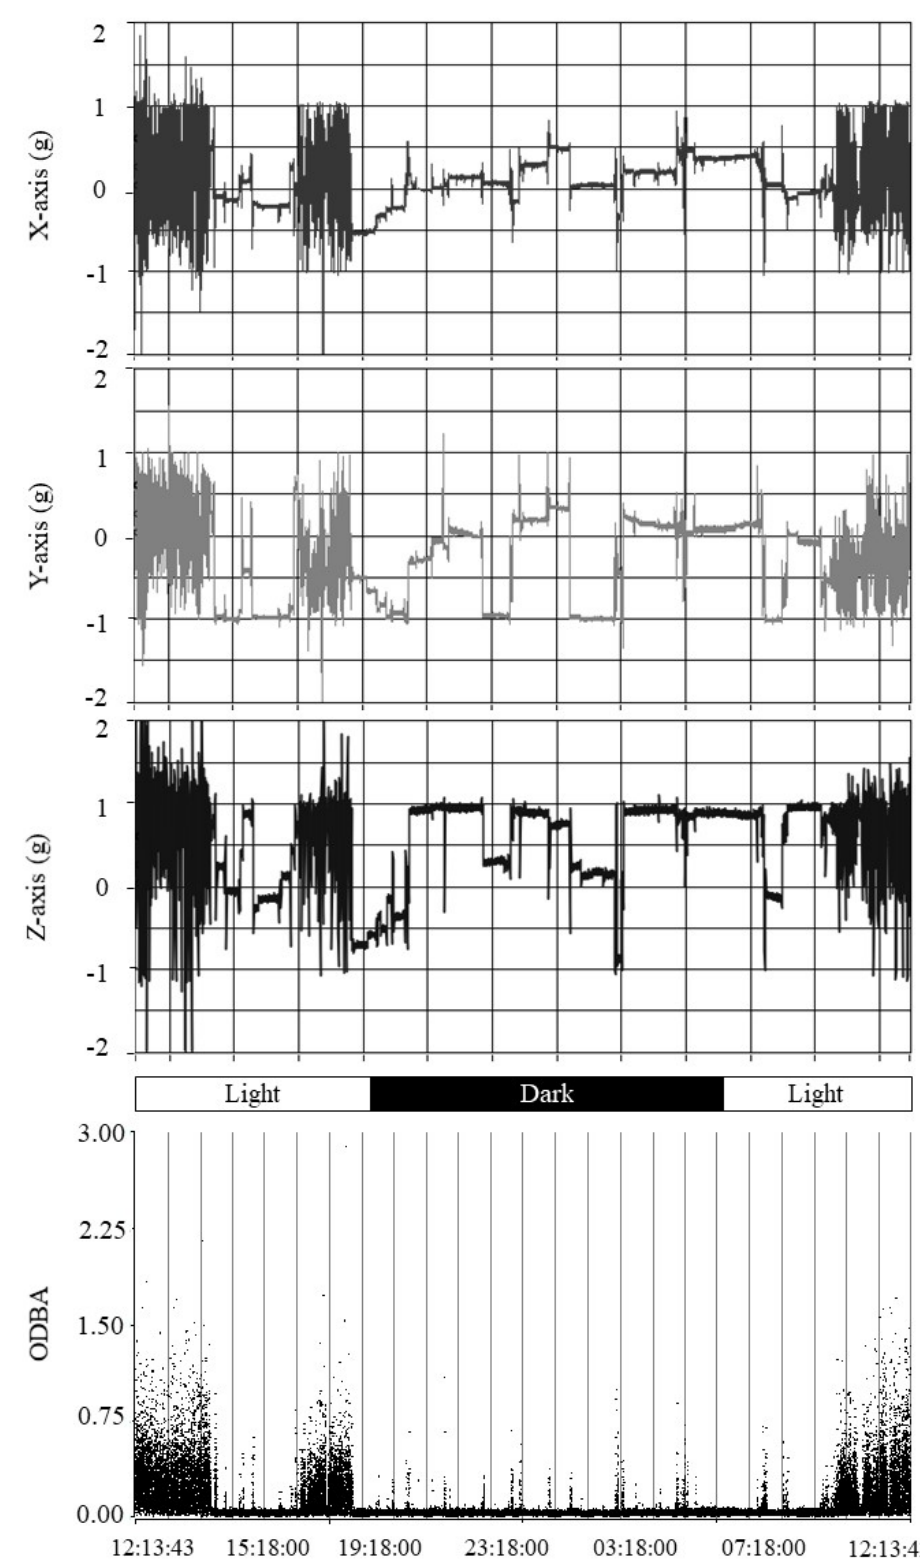
Figure 7. Profiles of the accelerometer data series (Panel A) and ODBA dot plot (Panel B) obtained during the 24 h pilot test carried out on an adult Tamandua tetradactyla individual exposed to semi- controlled conditions in its enclosure. Panels A–C: X, Y and Z axes. Panel D: vertical lines indicate 60 min periods throughout the test. Light and dark periods associated with light/dark photoperiodic phases are shown.